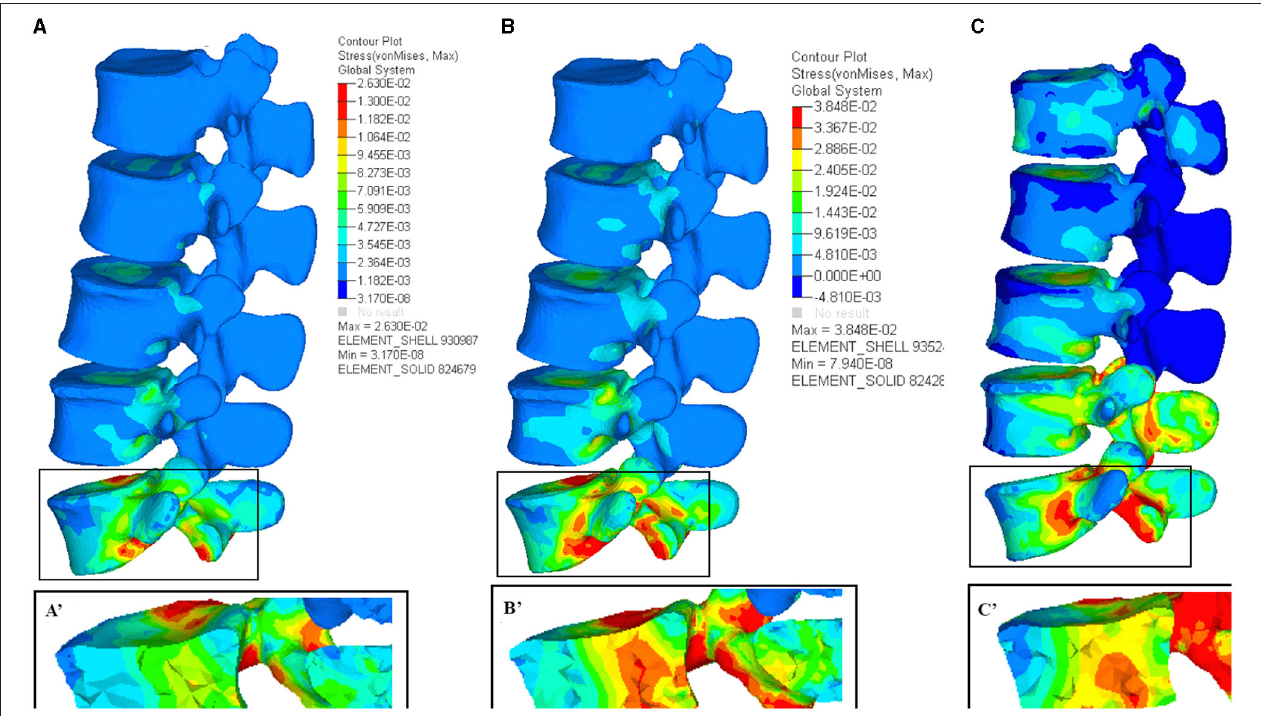
FIGURE 7 | The vertebrae effective stress contribution in bending without lifting weight posture (A) , the bending with lifting 3-year-old child posture (B) , and upright with 3-year-old child posture (C) , the A’, B’, and C’ were the detailed sagittal view of spongy bone of (A–C) respectively.